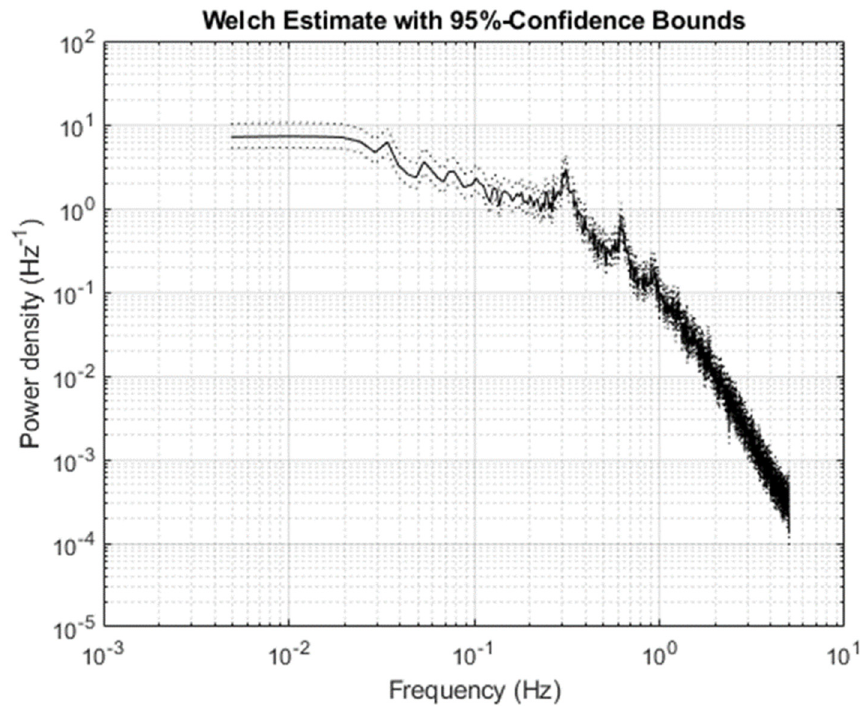
Figure 16. The variance-normalized power spectral density of the salinity fluctuations obtained in the experiment with the single oscillating grid.